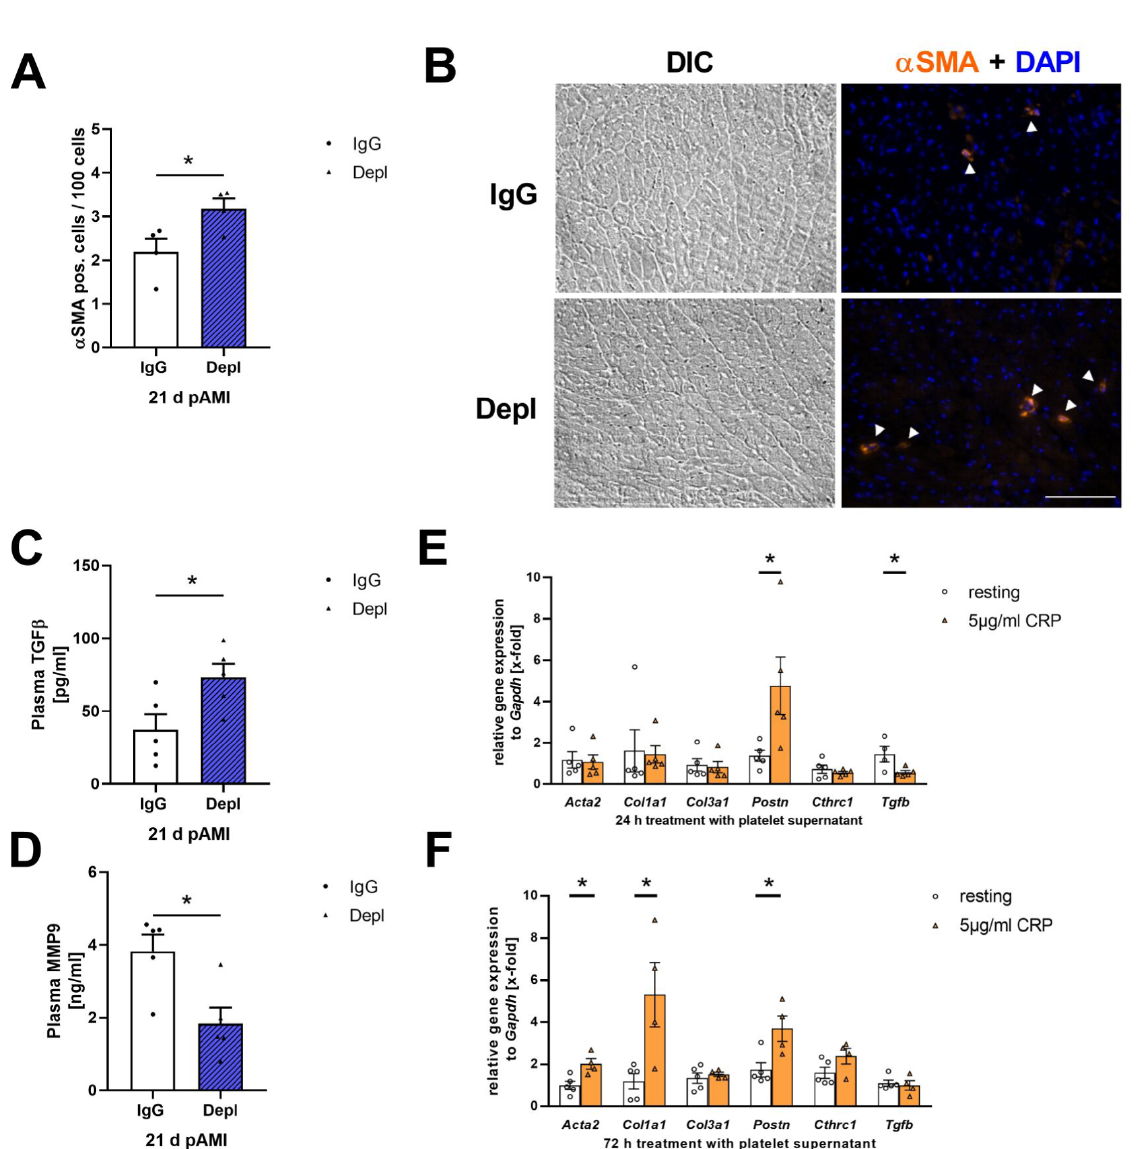
Figure 5. Platelets activation affect cardiac fibroblast activation and transformation in the remodeling phase after AMI. ( A ) Quantification and ( B ) representative images of α SMA positive cells (white arrows) in the infarcted myocardium of platelet depleted mice after 21 days of reperfusion compared to IgG injected control mice; n = 4. ( C , D ) Plasma levels of (C) TGF- β and ( D ) MMP9 after 21 days of reperfusion. n = 5. ( E , F ) Gene expression of Acta2 , Col1a1 , Col3a1 , Postn , Cthrc1 and Tgf β in isolated cardiac fibroblasts from wildtype mice treated with the supernatant of resting and CRP (5 µ g/mL) activated platelets for ( E ) 24 h or ( F ) 72 h; n = 4–5. Scale bar = 100 µ m. Data are presented as means ± SEM. Statistical analyses were done by two-tailed unpaired Student’s t -test. * p <